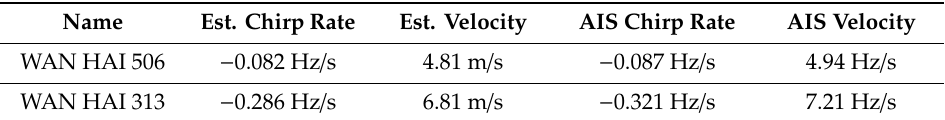
Table 4. The estimated results and ground truth from AIS.